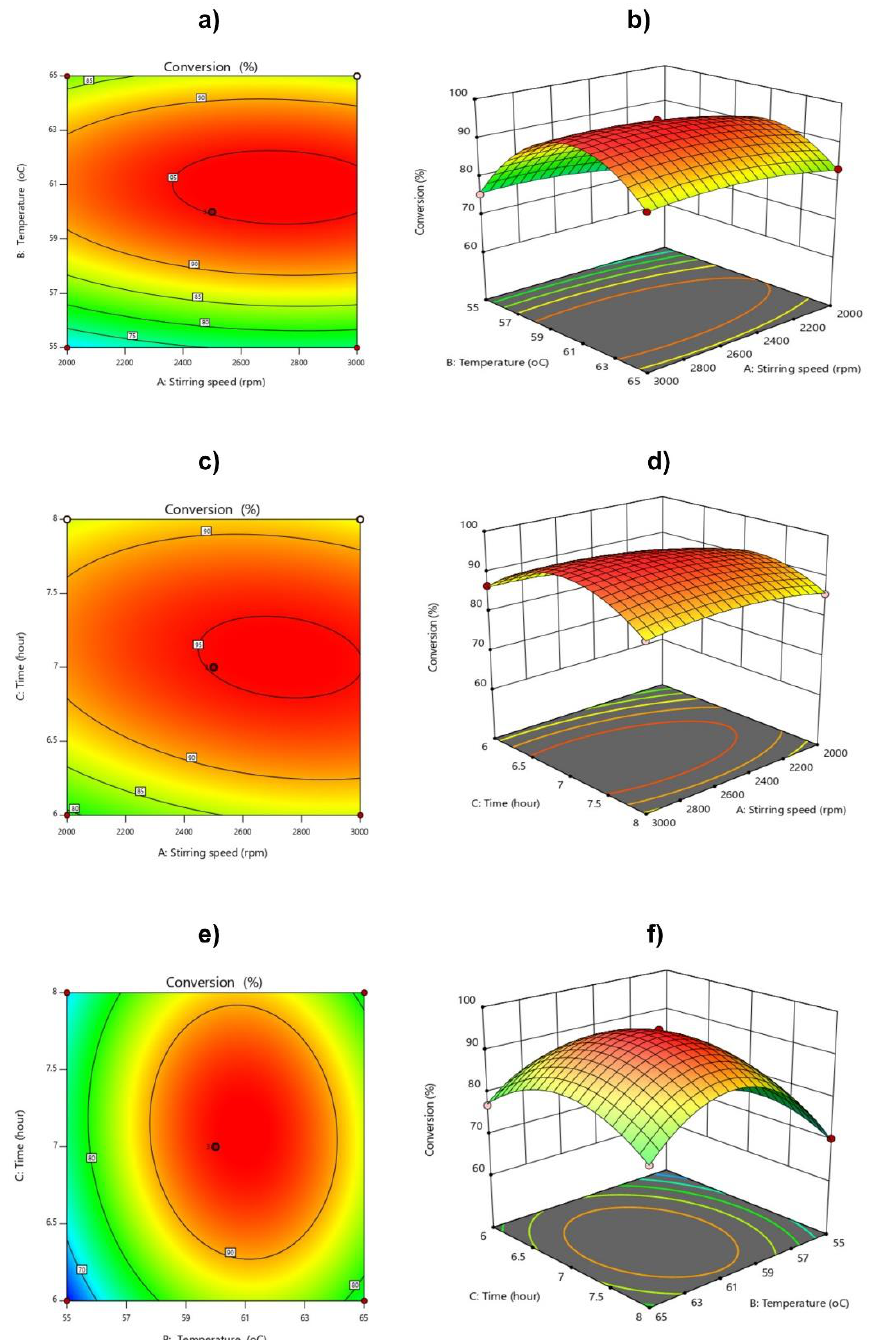
Figure 11. 2D contour graphs and 3D response surface: analysis of the interaction effects of stirring speed and temperature ( a , b ), stirring speed and time ( c , d ), and temperature and time ( e , f ) on conversion.